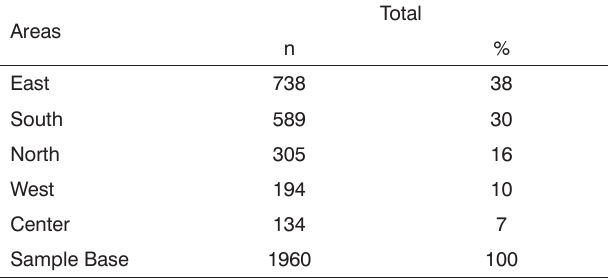
Table 1. Sample size (n) and percentage (%) of households visited according to the census of the city of São Paulo.